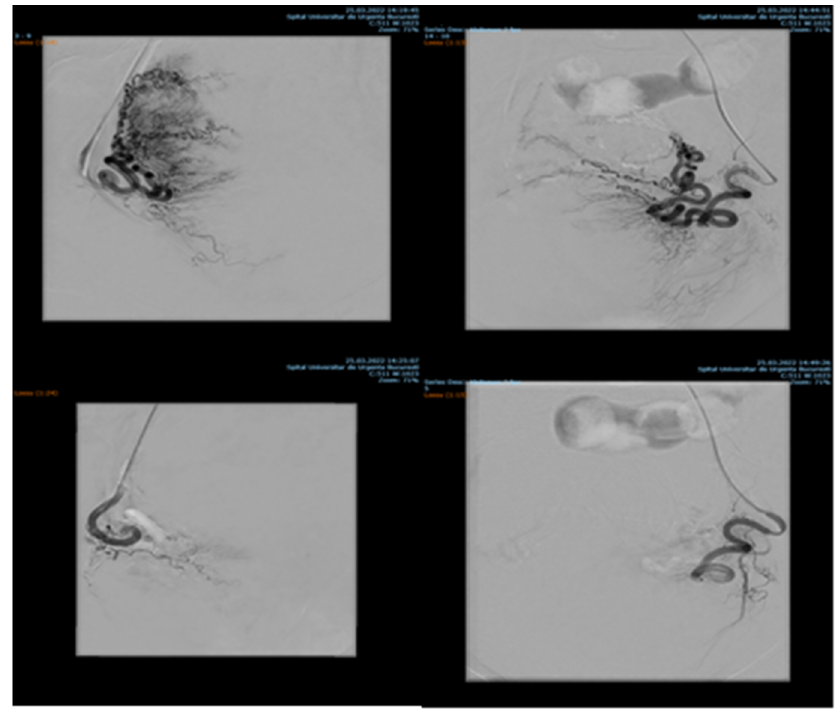
Figure 3. Selective long vaginal artery embolization in patient with cervical neoplasia.